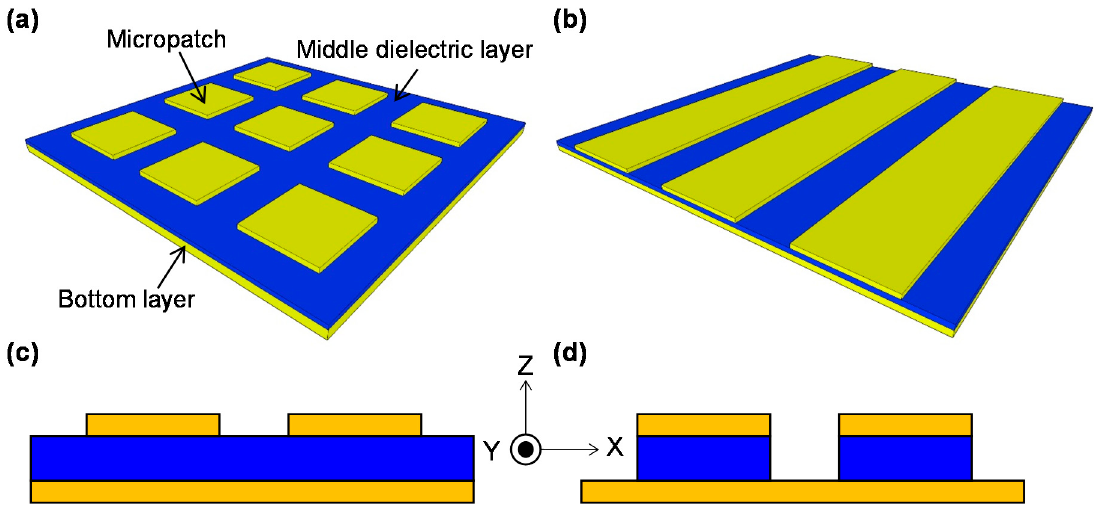
Figure 2. Schematic illustrations of metal ‐ insulator ‐ metal ‐ based plasmonic metamaterial absorbers (MIM ‐ PMAs); oblique view of ( a ) two ‐ dimensional (2D) and ( b ) one ‐ dimensional (1D) periodic micropatches. Cross ‐ sectional views of ( c ) continuous and ( d ) isolated middle dielectric layers.